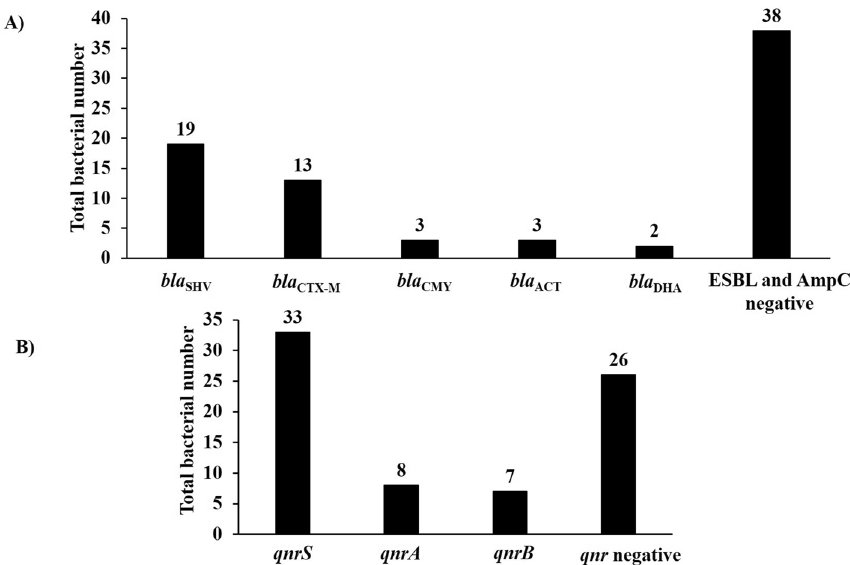
Figure 2. Molecular analysis of ESBL- and AmpC-encoding genes ( A ) and plasmid-mediated quinolone resistance genes ( B ). ( A ): bla SHV was the most prevalent ESBL-encoding gene (25.7%; 95% CI 16.2–37.2%) followed by bla CTX-M (17.6%; 95% CI 9.7–28.2%). Furthermore, 10.8% (95% CI 4.8–20.2%) of the isolates contained varying AmpC-encoding genes with bla CMY and bla ACT identified ones within three isolates for each and two isolates were confirmed to possess bla DHA-1 . ( B ) The plasmid-mediated quinolone resistance genes were identified within 64.9% (95% CI 52.9–75.6%) of the isolates, with qnrS was the most prevalent (44.6%; 95% CI 33.02–56.6%) followed by qnrA and qnrB detected within 10.8% and 9.5% of the isolates,